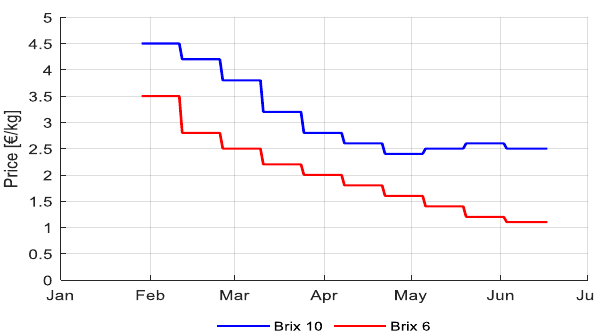
Figure A1. Tomato prices cv. Axiany (€/kg) depending on different Brix values (6 and 10) during the harvesting period (13 February until 29 May 2020).